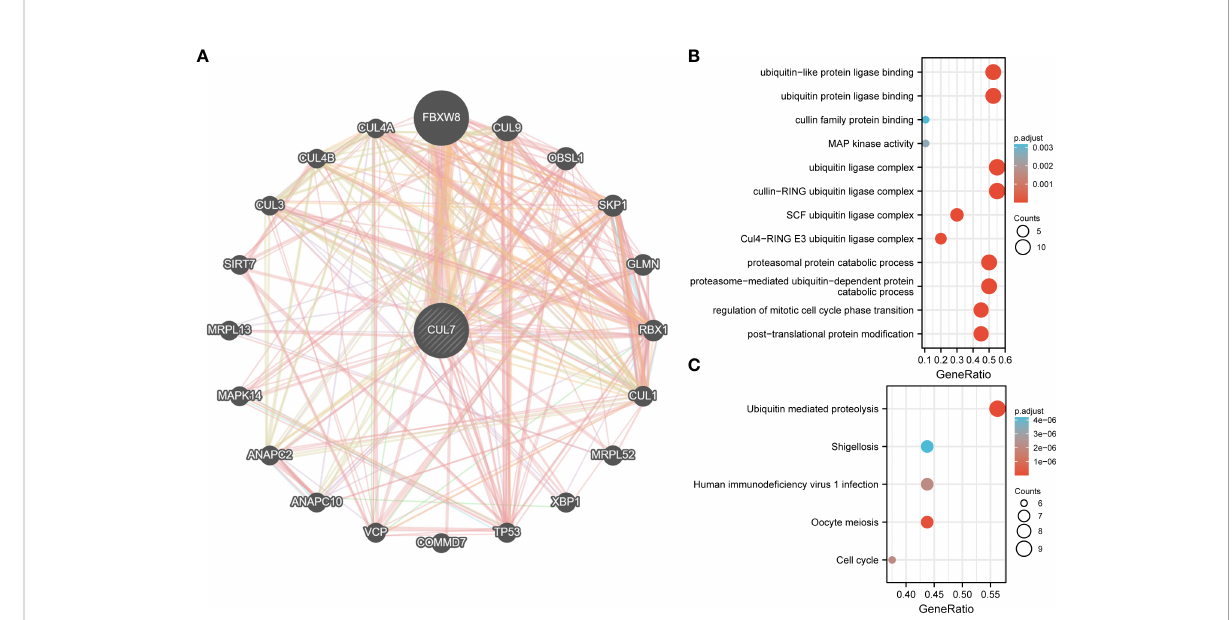
FIGURE 7 PPI network and functional enrichment analysis of CUL7. (A) PPI network of CUL7. (B) GO analysis of related genes. (C) KEGG analysis of related